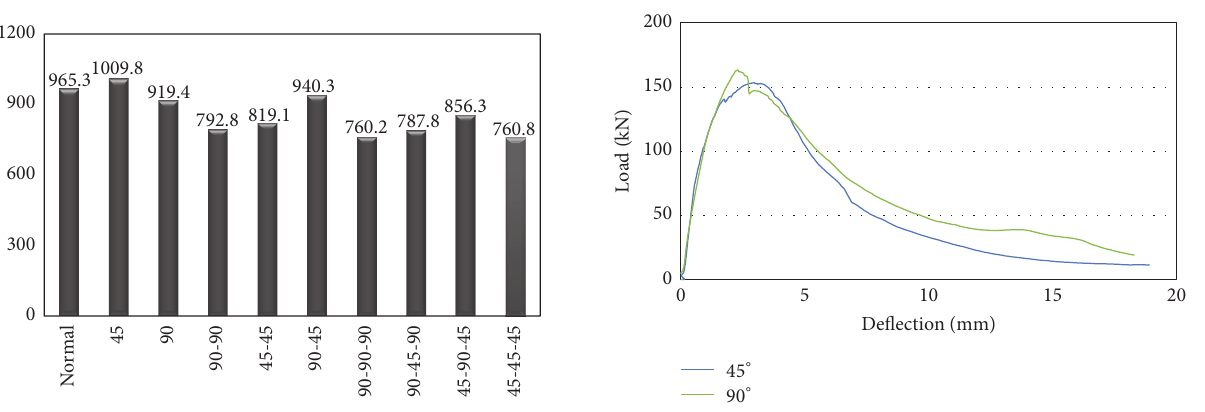
Figure 9: Flexural toughness of the BFRP HPFRCC beam.